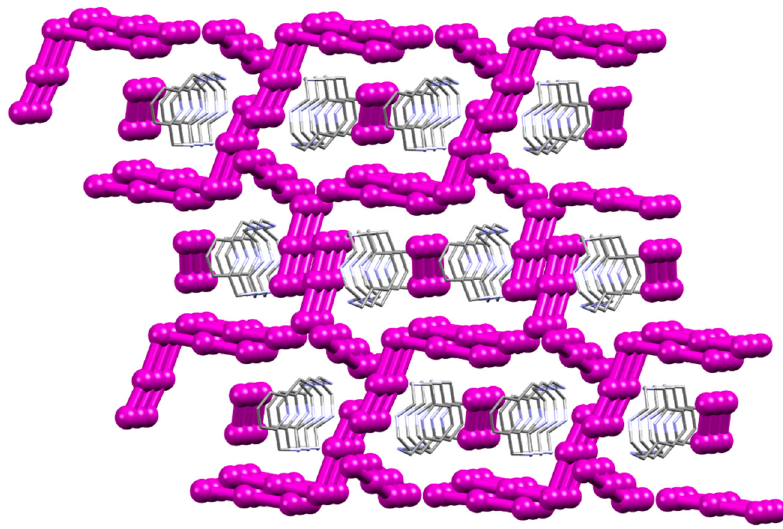
Figure 6. View of the lattice formed by polyiodides and iodine molecules resulting in a self-assembled clathrate structure trapping the H 2 L1 2+ counterions in its cavities. Color code: grey, C; cyan, N; violet,